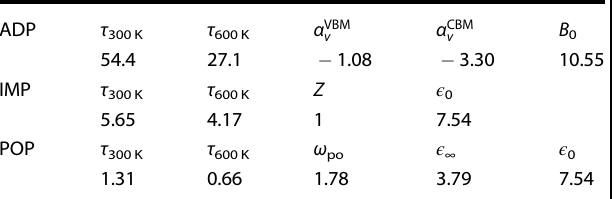
Table 1. Three types of electron scattering mechanism are considered as implemented in AMSET 44 : (i) acoustic deformation potential (ADP); (ii) ionized impurity (IMP); (iii) polar-optical phonon (POP). τ T are the lifetimes for a given scattering process at T in unit of fs where electron concentration is assumed to be 4 × 10 18 cm − 3 , α VBM volume deformation potential of valence band maximum (VBM) and conduction band minimum (CBM) in unit of eV, B 0 is the bulk modulus in unit of GPa, Z is the charge of electron donor dopant, ϵ 0 is the static dielectric constant, ϵ ∞ is the electronic contribution to the static dielectric constant, and ω po is the polar-optical phonon frequency in THz.